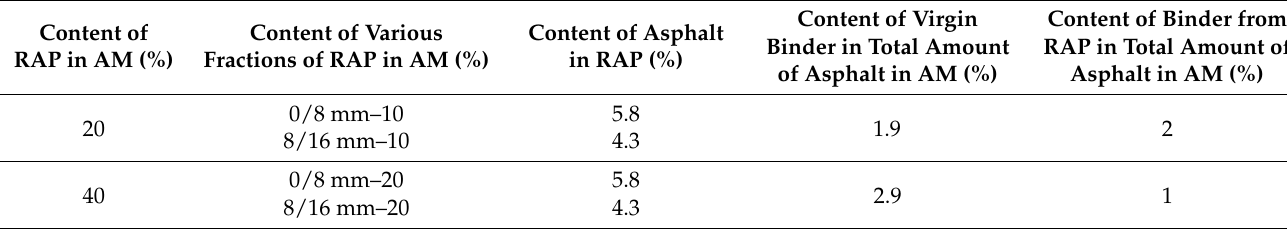
Table 4. Binder content in the